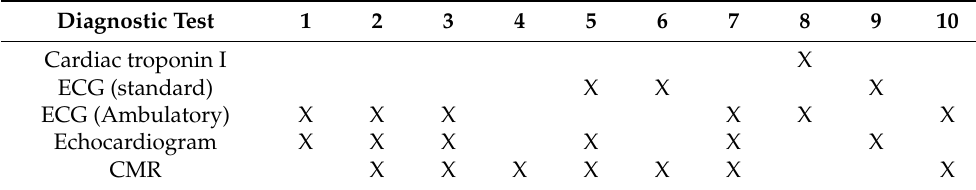
Figure 1. Classification of abnormalities by diagnostic tests including CMR (n = 7), echocardiography (n = 6), ambulatory ECG (n = 6), and cTnI (n = 1) in 10 naturally infected dogs with chronic Chagas disease. CMR, cardiac magnetic resonance imaging; cTnI, cardiac troponin I. Table 3. Diagnostic test abnormalities including cardiac magnetic resonance imaging (CMR) in each of the 10 dogs with chronic Chagas